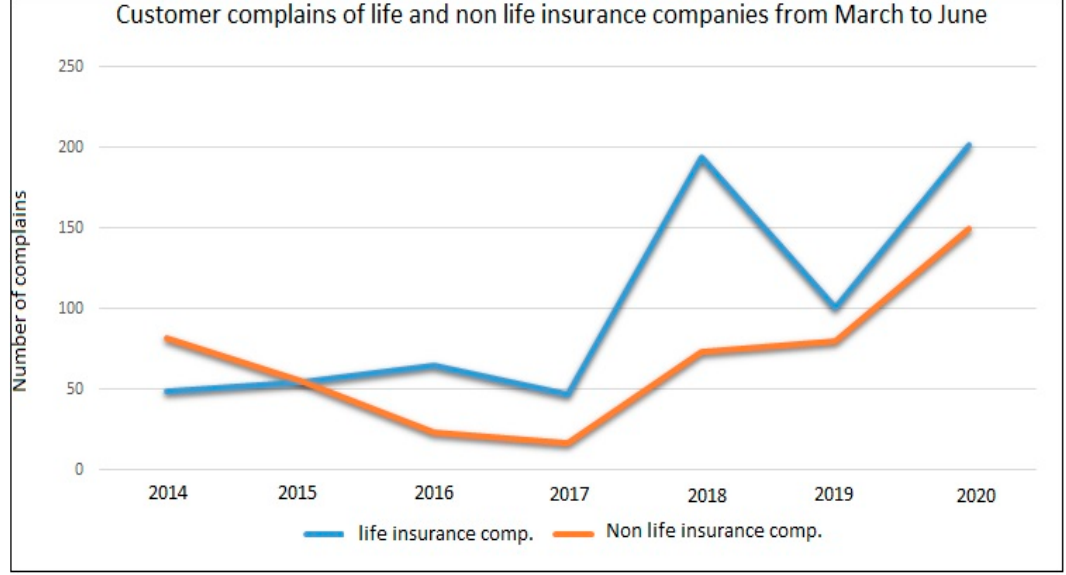
Figure 2. Comparison of customer complaints in the insurance industry within the period under review.